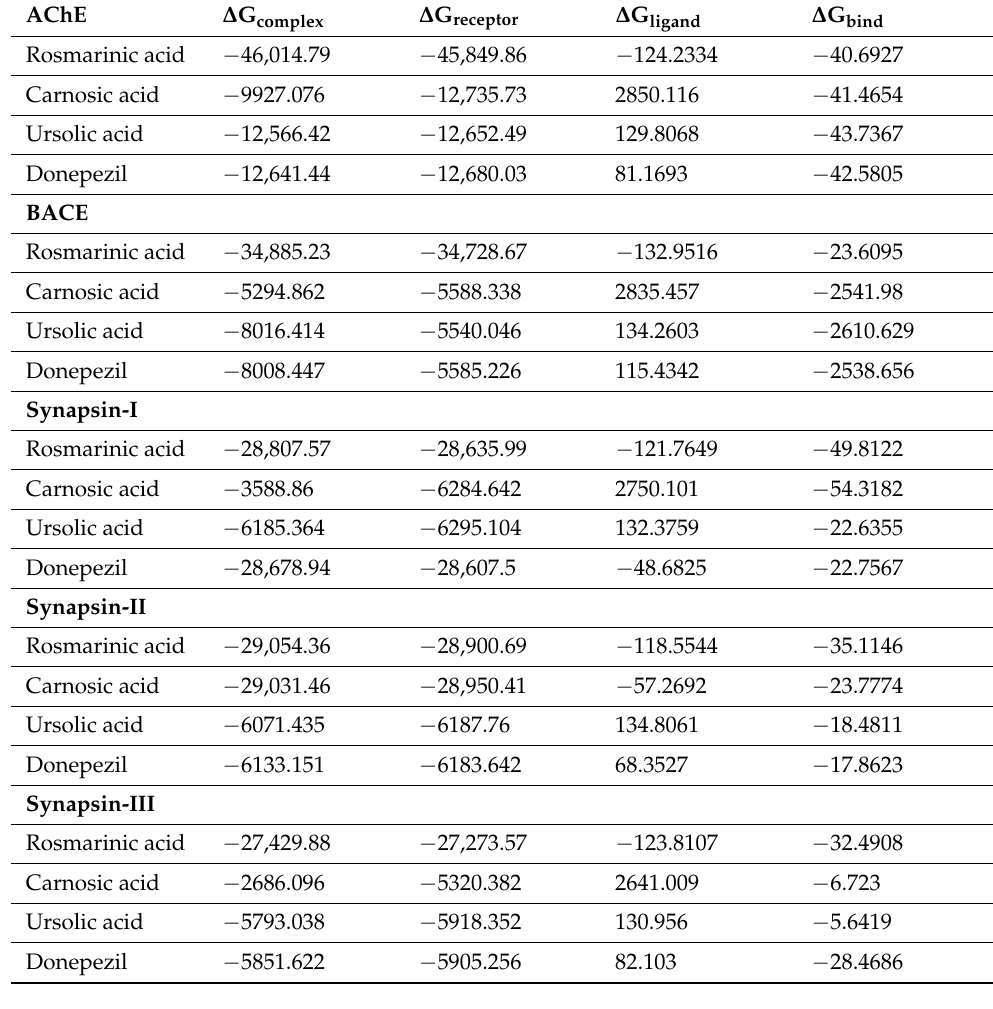
Table 2. MM-GBSA binding free energy of of R. officinalis active compounds with the target proteins.